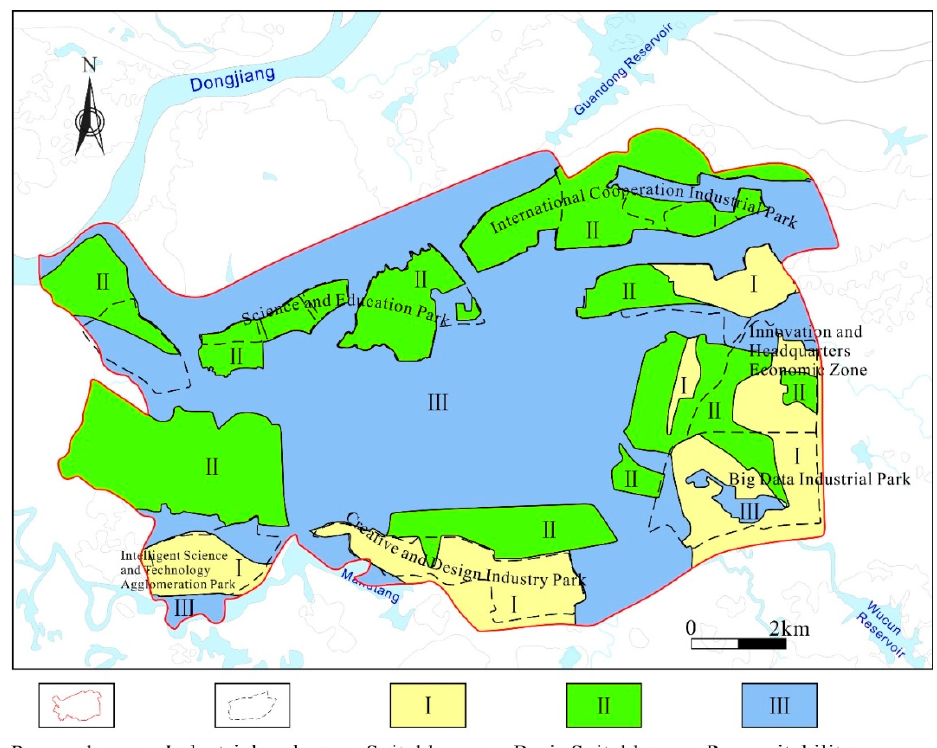
Figure 9. Suitability for zoning of the shallow underground space within 15 m.